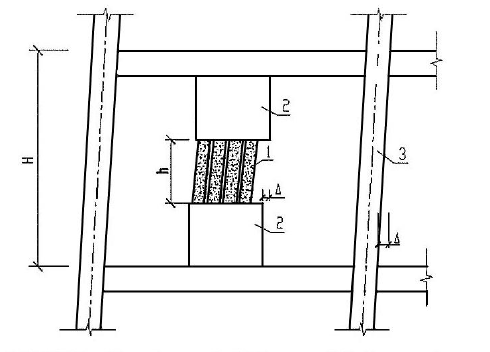
Figure 1. The working principle of CFST damper.